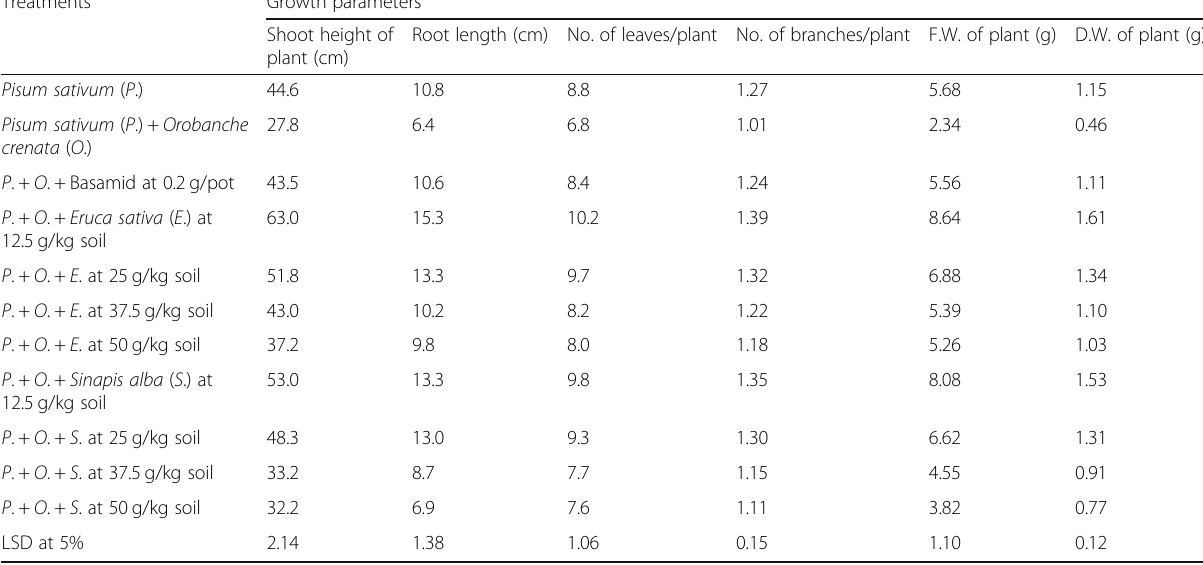
Table 2 Effect of different rates of both Eruca sativa and Sinapis alba seed powder and herbicide Basamid on growth parameters of Pisum sativum at 30 days after sowing (combined analysis of two seasons) Treatments Growth parameters Shoot height of Root length (cm) No. of leaves/plant No. of branches/plant F.W. of plant (g) D.W. of plant (g) plant (cm) Pisum sativum ( P .) Pisum sativum ( P .) + Orobanche crenata ( O